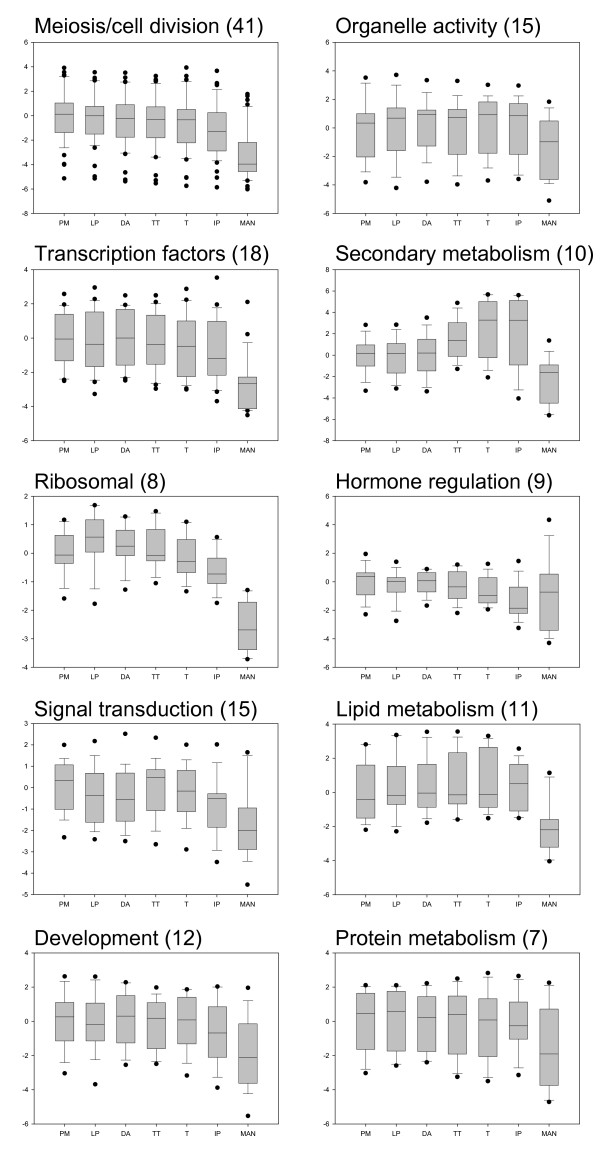
Functional classifications and expression analysis from the developing wheat anther. Transcripts were pooled into categories based upon their annotations and having satisfied the following criteria: an E-value < e-30, a sequence length > 250 bp and their cross-hybridizing status (based on the Affymetrix designation). The data for each functional category is represented as log base 2, RMA normalized values that were centered on the average of the pre-meiosis (PM) value. Representations (n) assigned to each functional category are indicated in brackets.